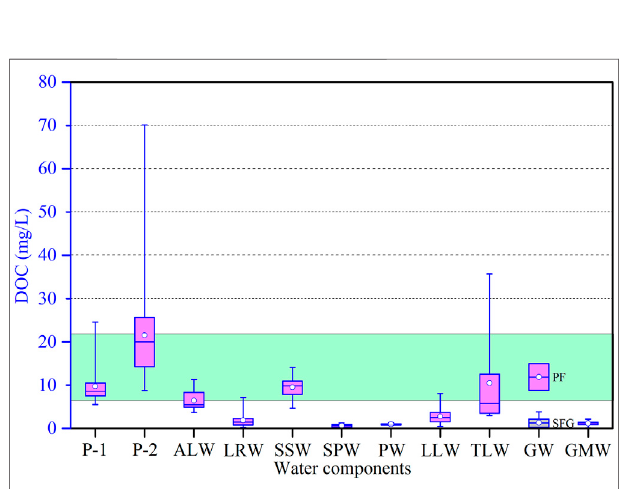
FIGURE 5 | Comparison of DOC in different water components on the